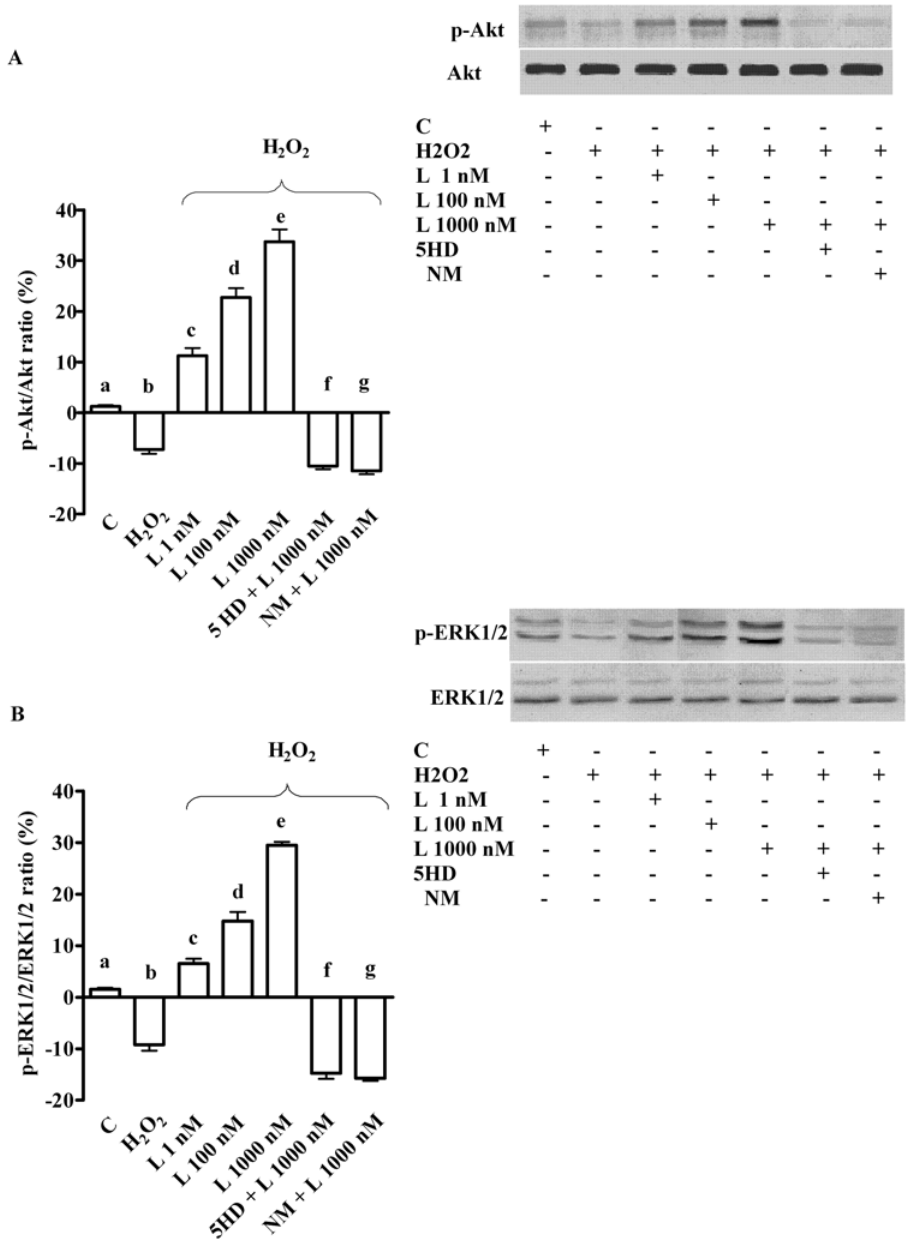
Fig 8. Effects of levosimendan on cell survival signalling in hepatocytes subjected to peroxidation. In A and B, effects of levosimendan on p-Akt and p-ERK1/2, respectively. Densitometric analysis and an example of lanes taken in one of the 5 different experiments performed for each experimental protocol are reported, as well. Abbreviations are as in previous Figures. b, c, d, e, f, g P < 0.05 vs a; c, d, e, f, g P < 0.05 vs b; d, e P < 0.05 vs c; d, f, g P < 0.05 vs e. The results of densitometric analysis are expressed as means of 5 independent experiments (%) ± SD (indicated by the